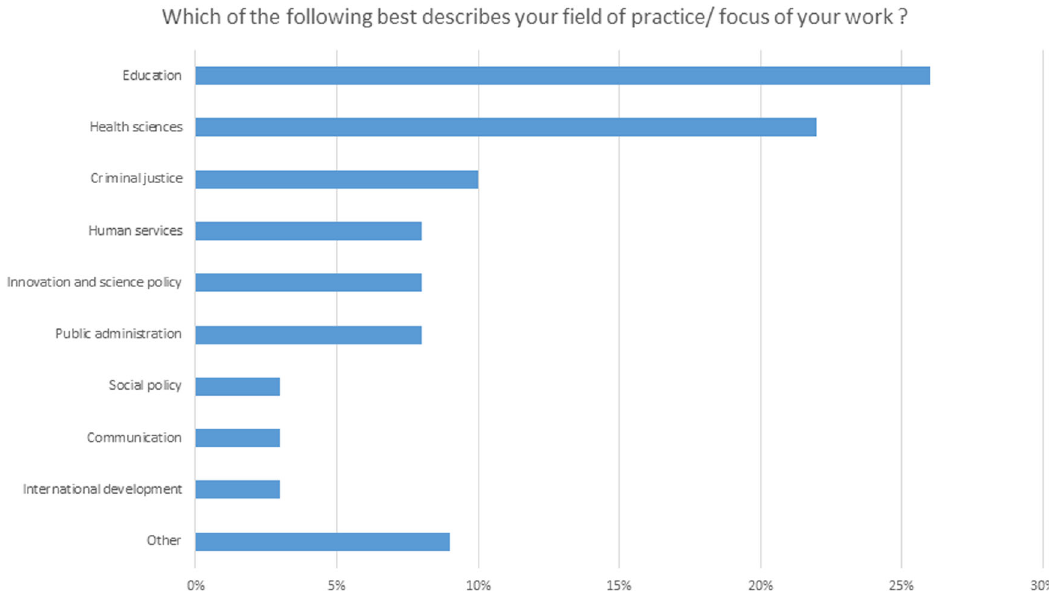
Fig. 1 Fields of practice. Survey respondents ’ indicated the primary fi eld of practice in which they work. Bars indicate the percentage of respondents indicating each